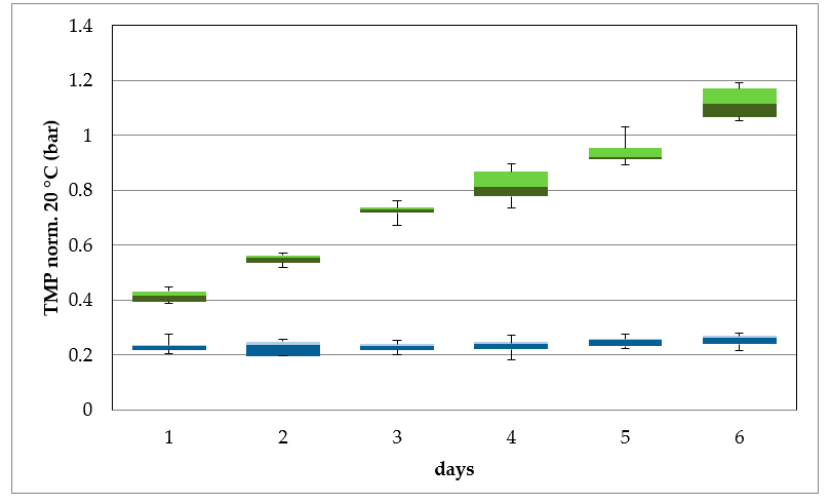
Figure 5. The increase in transmembrane pressure (TMP) for UF 1 during filtration of Elbe River water (green) and bank filtrate (blue). TMP was standardized over temperature. Flux was 50 L/m² h. The TMP increase was 0.14 bar/day for RW and 0.005 bar/day for BF. A significant difference in the fouling potential of the different membrane manufacturers (UF 1, UF 2) was not found (see Table 2). Table 2. A comparison of the fouling potential of both membrane types with differentiated flux.